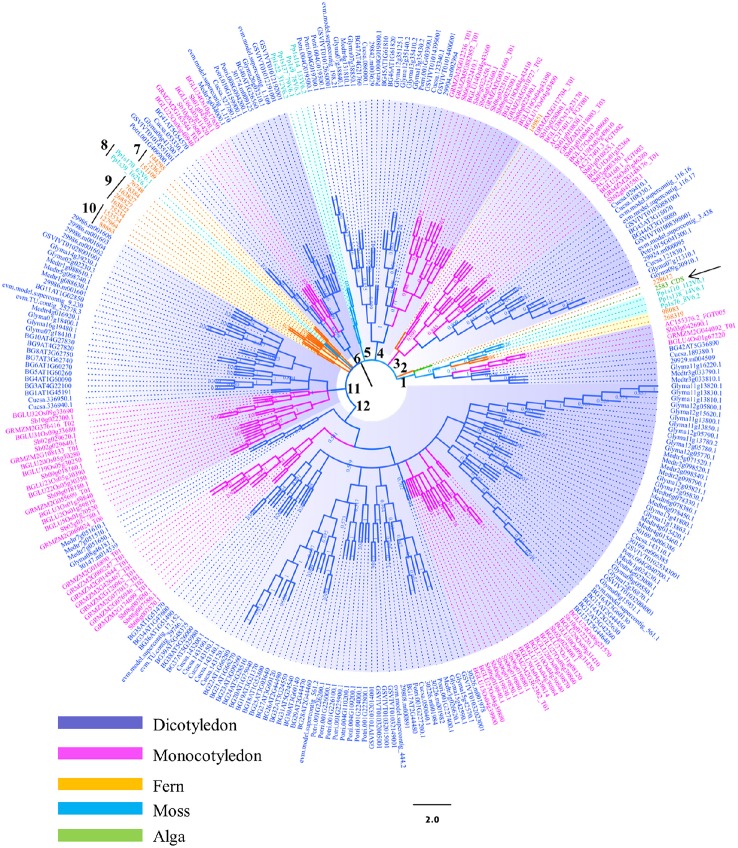
Phylogenetic analysis of the β-glucosidases in plant lineage. Phylogenetic analysis of plant β-glucosidases using neighbor-joining (NJ) methods as implemented in MEGA 4.0. Three hundred and four sequences selected from different plant species were used to construct the evolutionary tree. The assigned gene identifiers or accession numbers for the genes are displayed. Bootstrap values are recorded at the nodes. Abbreviations of generic names are listed in the Materials and methods and Table S1.